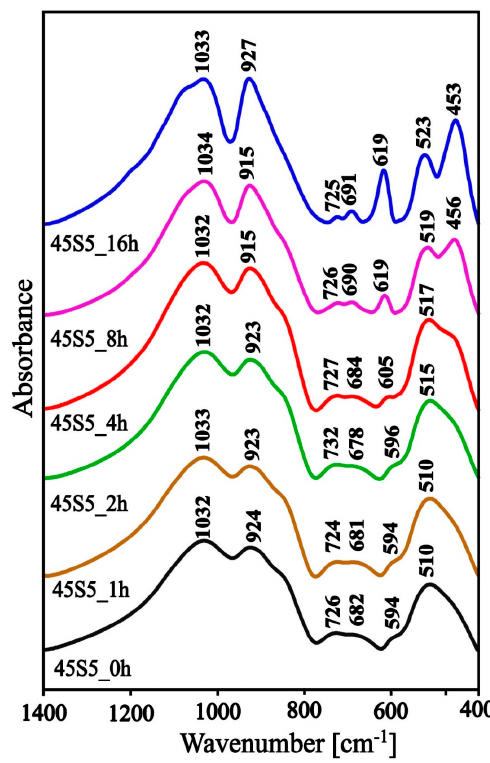
Figure 8. Middle infrared region (MIR) spectra of the 45S5_0h glass and glass-ceramic samples heated in 620 ° C at times of 1, 2, 4, 8, and 16 h.